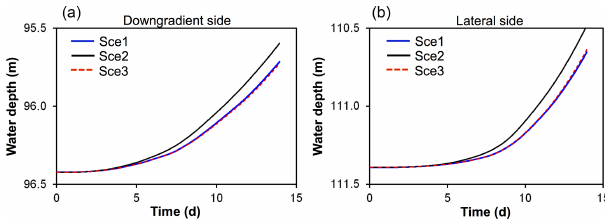
Figure 4. Piezometric head evolution at two observation points. Piezometric head is computed at the downgradient (a) and lat- eral (b) sides of the Martelange mine.